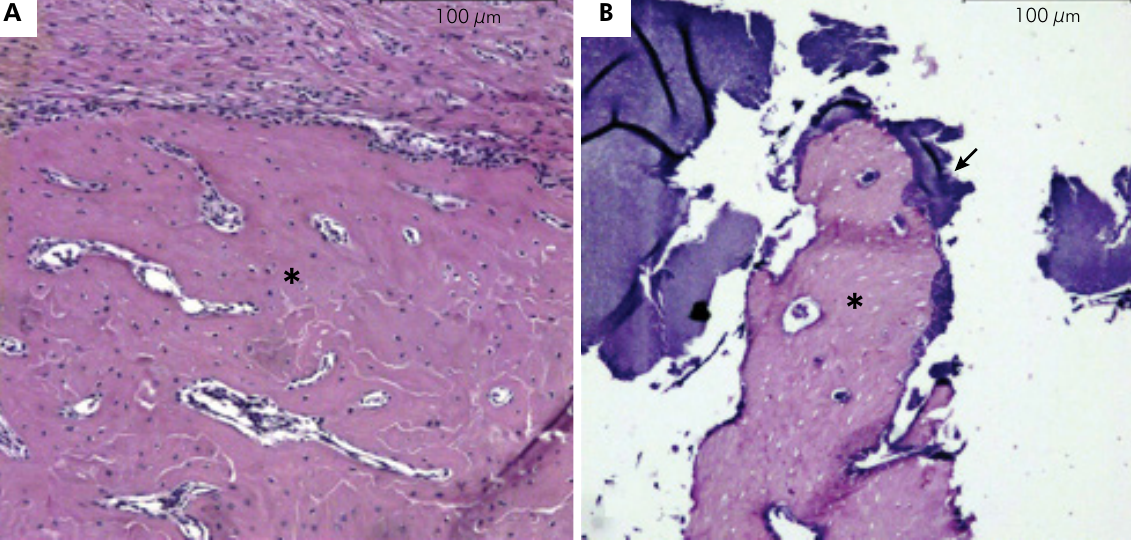
Figure 2. Histologic sections of tooth sockets 28 days after left lower first molar extraction and stained with hematoxylin and eosin. The animals in CTL group (A) demonstrated alveolar socket area completely remodeled, with no signs of bone necrosis (asterisk), while in the ALN group (B) it was observed the inter-radicular septum retention, which was associated with bone necrosis (asterisk) and infection (arrow; original magnification